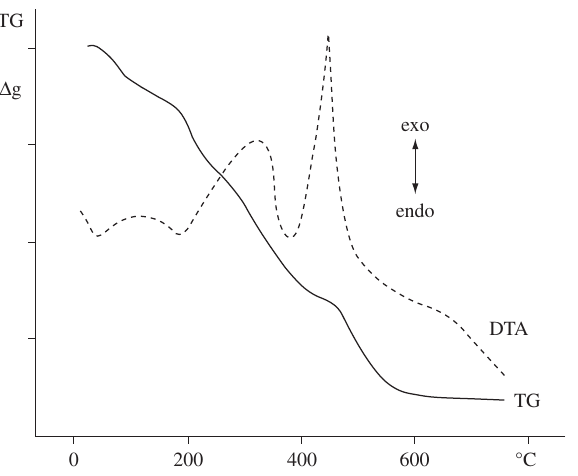
Figure 1. TG and DTA traces of the thermal decomposition of a calcium fructoborate sample.